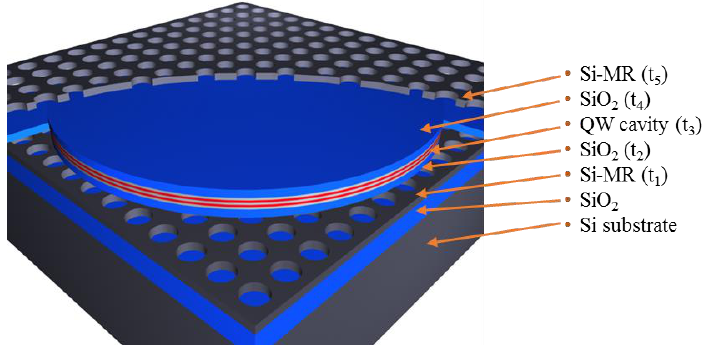
Figure 8. Schematic of MR-VCSEL lasing cavity structure, which consists of five layers (t1–t5): an InGaAsP QW cavity sandwiched between two single layer Si Fano resonance PC membrane reflectors (Si-MRs), stacked on a Si substrate. Low index SiO 2 buffer layers are inserted to ensure high reflection of